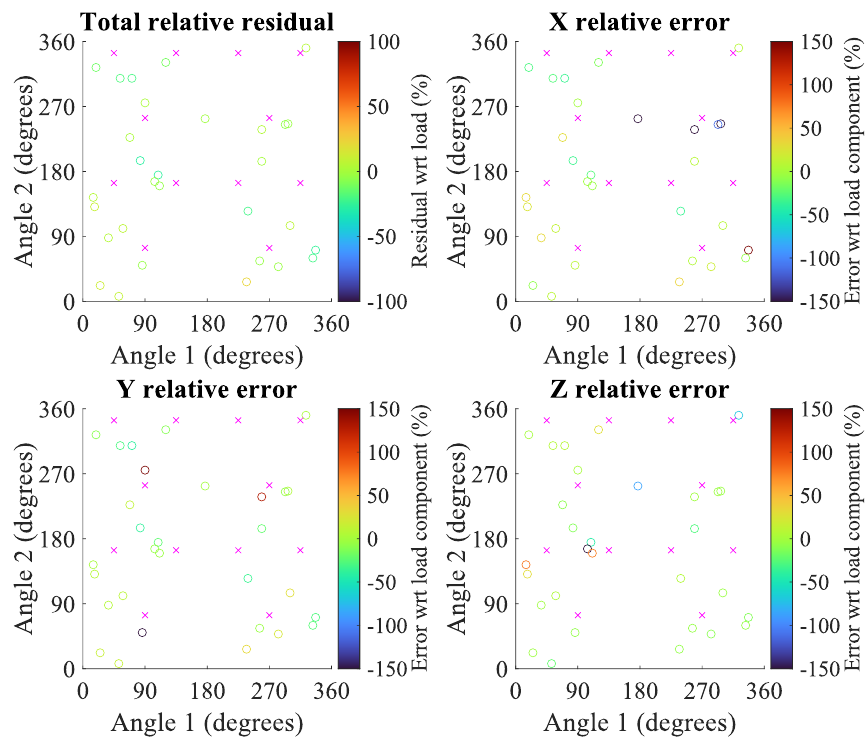
Figure 21. Relative percents of overall loading residuals and axial-component errors as a function of C-space angular orientation, normalized to either the total applied load or respective applied load component (x, y, or z). Magenta crosses indicate the positions at which the sensor was calibrated (with mirrored counterparts), while the circles indicates at what angular positions the errors were sampled and how large they were (indicated by color) for the component or system. Relative component error scaling is limited to 150% in magnitude for easier interpretation of color differences at smaller errors. Component errors more negative than − 100% indicate actual and anticipated loads used to calculate error have inverted